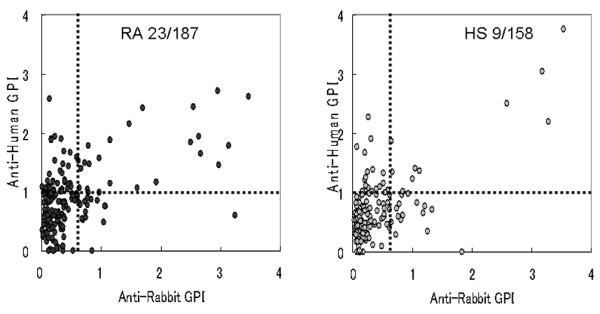
Population of anti-GPI antibody positive individuals, and FCGR3A and FCGR2A genotypes. The study included 187 patients with rheumatoid arthritis and 158 healthy Japanese individuals. The horizontal and vertical dotted lines represent the cutoff optical density values calculated from ELISA reactions of 158 healthy individuals for human recombinant GPI and rabbit native GPI, respectively. Individuals positive for both antibodies were considered anti-GPI antibody positive. Numbers in each graph represent the proportions of individuals positive for anti-GPI antibodies relative to the total number of individuals in that group. GPI, glucose-6-phosphate isomerase; HS, healthy subjects; RA, rheumatoid arthritis.